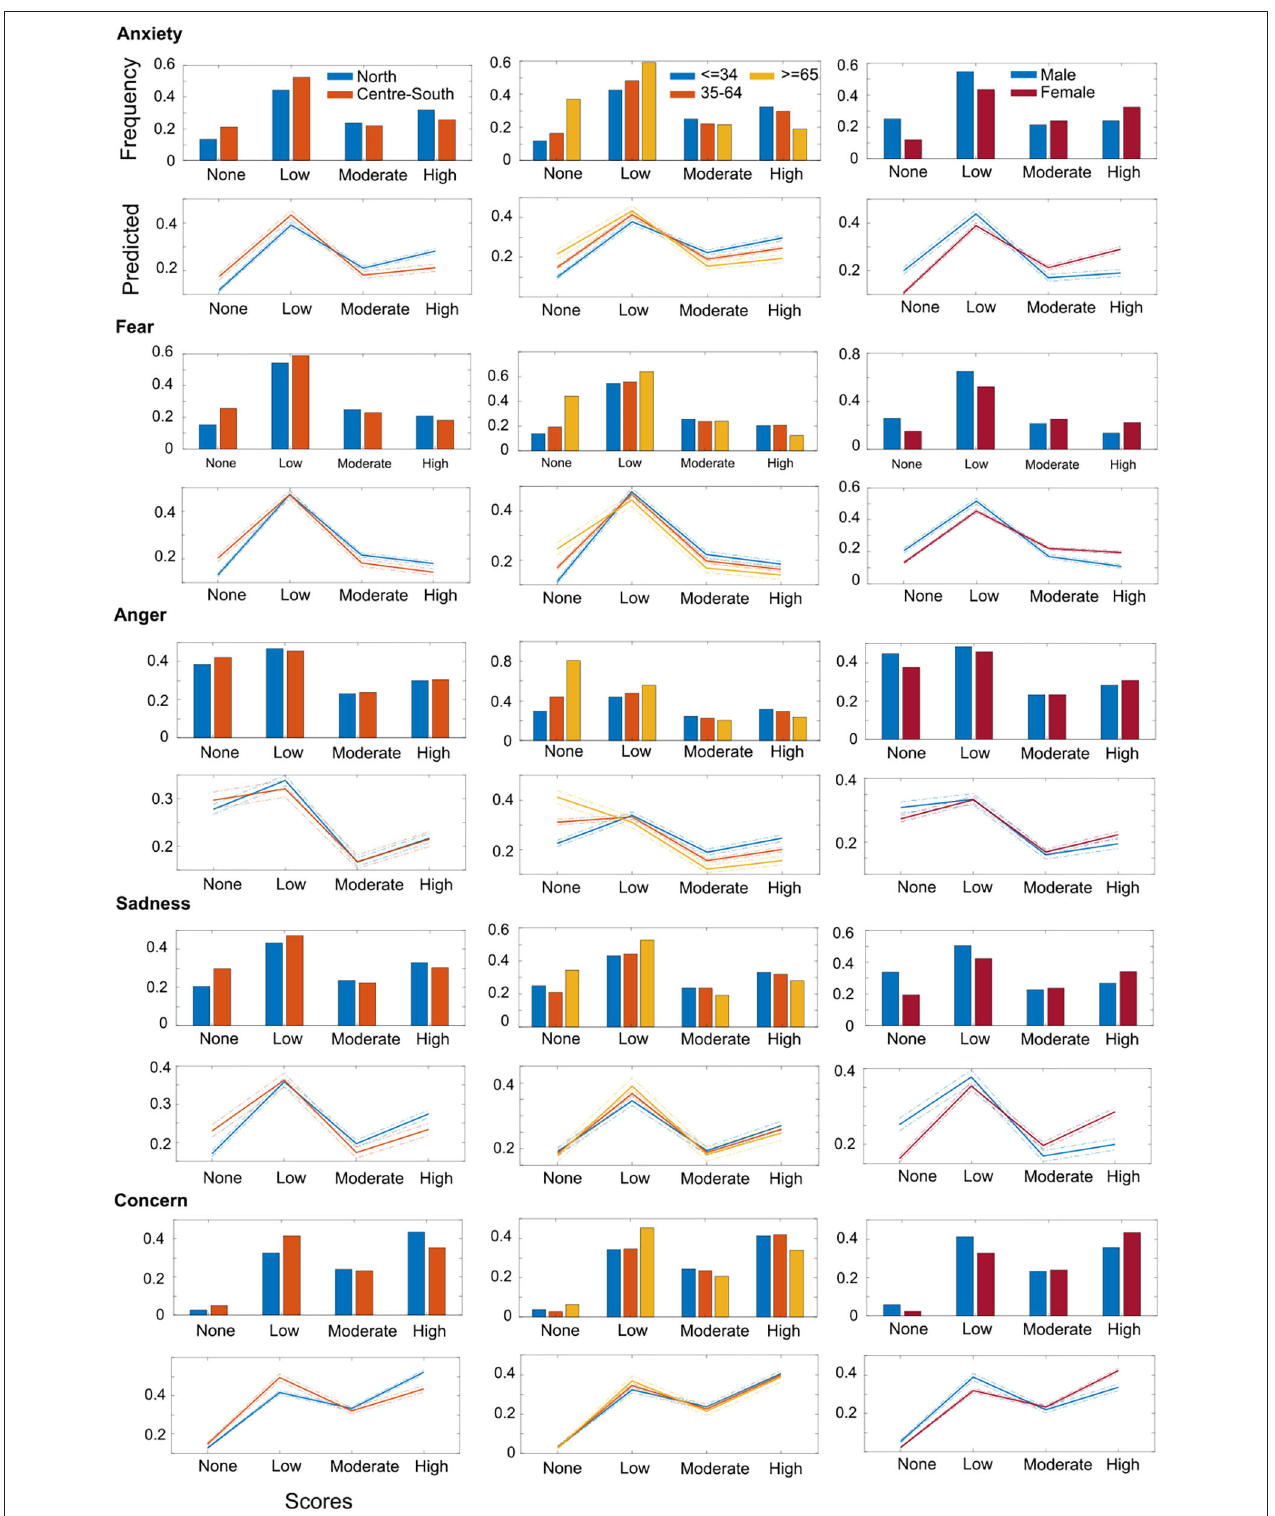
FIGURE 1 | Multinomial logistic regression data for psychological impact (anxiety, fear, anger, sadness, concern) score (none, low, moderate, high) and demographic factors (Region, Age, and Gender). Top Panel: bars represent the frequency count of scores normalized over the total number of each demographic factor. Bottom panel: predicted category counts (marked line) for the multinomial logistic regression model and 95% confidence bounds.